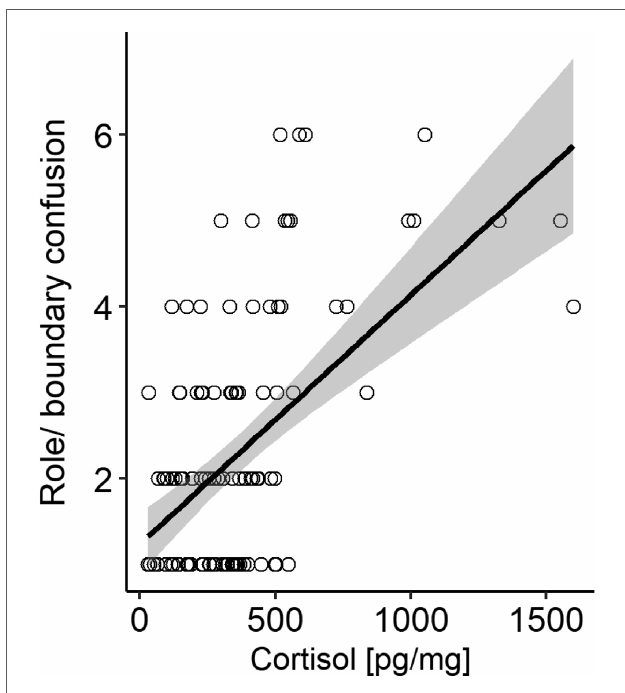
FIGURE 2 Scatterplot with HCC (pg/mg) raw data for robust regression model including AMBIANCE scale role/boundary confusion as predictor. Grey areas depict the 95% con fi dence